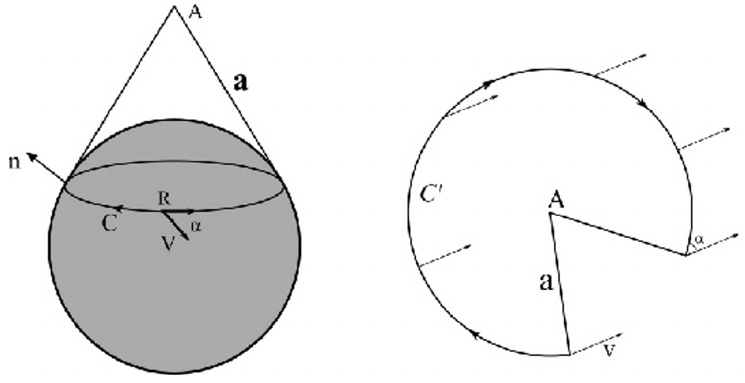
Figure 7: Pancharatnam - Berry Phase: suppose we travel on a closed path C Figure 3. Pancharatnam —Berry Phase: suppose we travel on a closed path C on a sphere (Earth) on a sphere (Earth) while holding a vector V paralell to the surface, i e in the local tangent plane (Figure 1.2). At each point, V does not twist around the while holding a vector V paralell to the surface, i.e. in the local tangent plane. At each point, V does local vertical axis (the local normal vector n). This is known as paralell not twist around the local vertical axis (the local normal vector n). This is known as paralell transport transport of V around C . When we return to the starting point, we (cid:133)nd that of V around C . When we return to the starting point, we find that in general V makes an angle α ( C ) in general V makes an angle (cid:11) ( C ) with its initial direction: the angle, which with its initial direction: the angle, which depends only on the particular path C is known as the depends only on the particular path C is known as the geometric angle, and is the classic analog of the Pancharatnam - Berry phase in quantum physics, see geometric angle, and is the classic analog of the Pancharatnam—Berry phase in quantum physics, e.g. Ong and Lee [15] see, e.g., Ong and Lee only to (cid:133)nd out that time went slower at the initial location so at their return they had e⁄ectively won their bet. This literary piece illustrates the "time line" break in time, so that if one starts traveling around the world along a path such as C in Figure 7 at the end of the journey when one goes all around the world and reaches the initial position, the time measured by a traveling watch will be di⁄erent than the time at the initial position at the moment of return, measured by a stationary watch. It can be shown that the topological problem posed by Jules Verne is the same as in the Pancharatnam Berry phases. It is well accepted that Barry phases arise from the existence of a singularity, which is the same origin that is postulated here for the basic properties of quantum theory that are described above, a topic that has to be discussed in further writings.